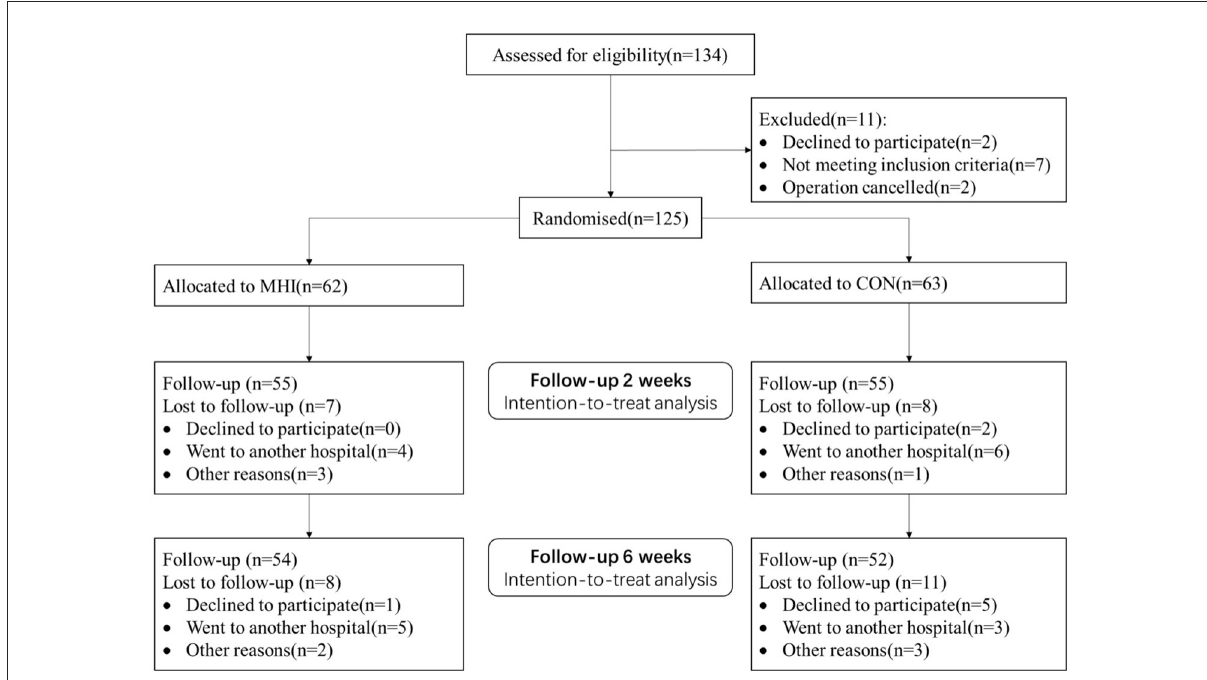
FIGURE3 Study participant flowchart (CON, Control group; MHI, mHealth intervention